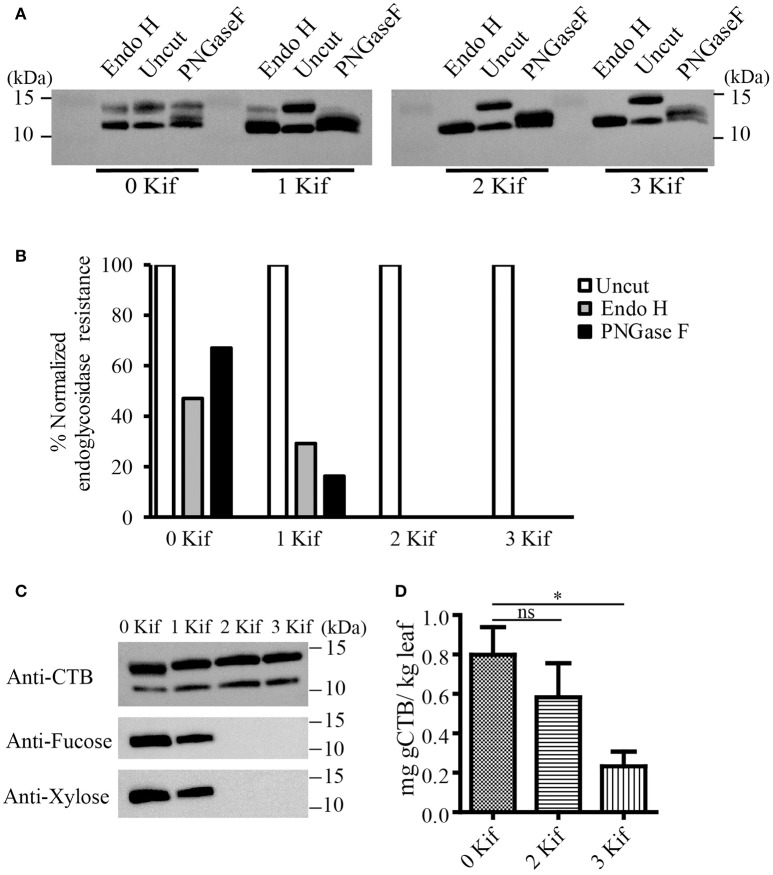
Endoglycosidase digestion of gCTB. (A) A representative immunoblot showing gCTB treated with a mock control (uncut), Endo H or PNGase F upon 0, 1, 2, and 3 kif treatments. (B) Densitometric analyses to calculate the fraction of glycosylated band resistant to either of the enzymes. Band intensity was normalized by calculating the fraction of residual undigested glycosylated gCTB band remaining after overnight digestion with respective glycosidases over glycosylated band intensity of an undigested gCTB sample, both receiving similar doses of kifunensine treatment. (C) A representative immunoblot showing gCTB from 0, 1, 2, and 3 kif conditions probed with α-fucose and β-xylose antibodies. (D) The quantification of gCTBkif in N. benthamiana using GM1-ELISA from clarified extracts. Statistical significance was analyzed by one-way ANOVA followed by Bonferroni's multiple comparison tests [*P < 0.05; ns, not significant (P > 0.05)].